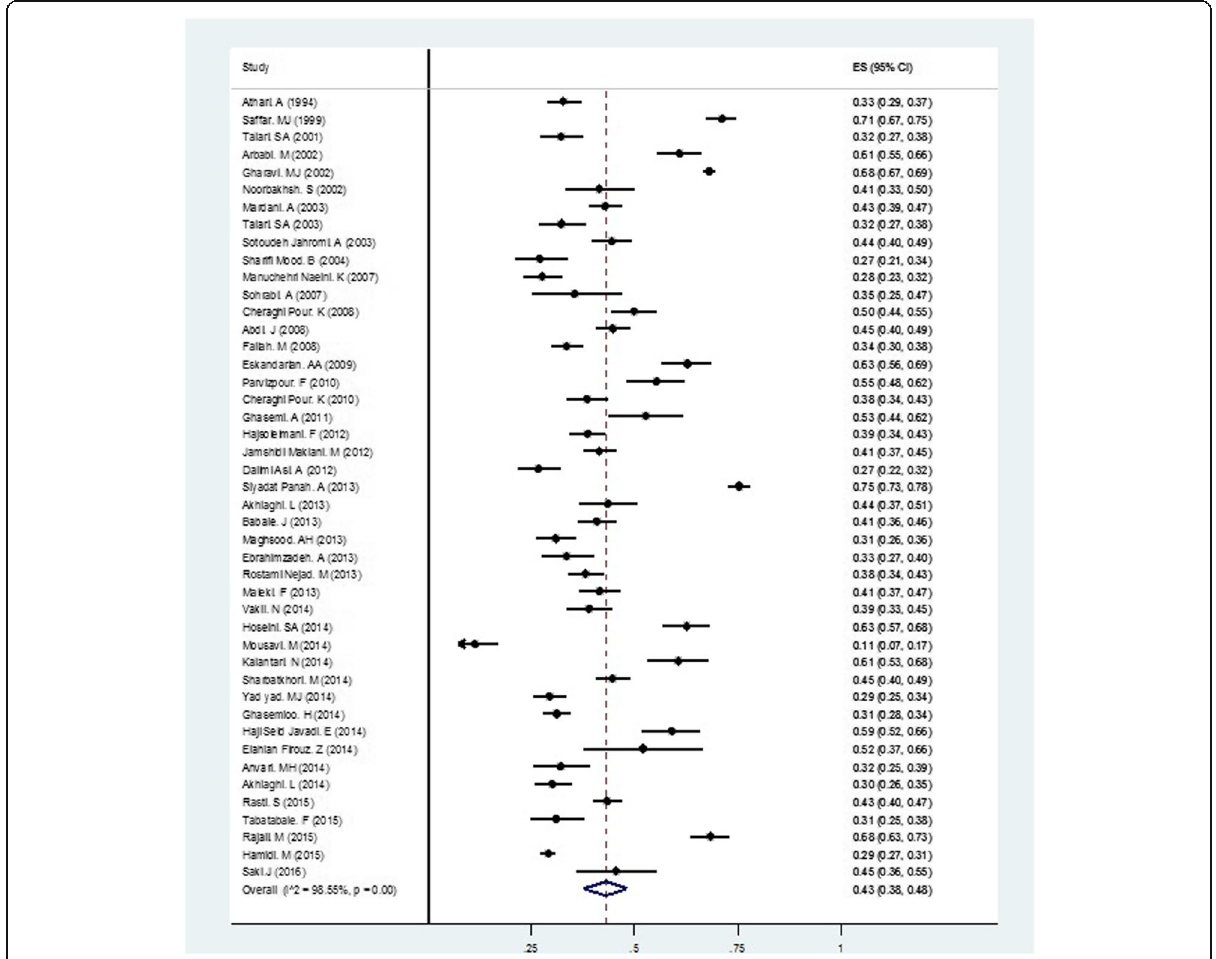
Fig. 3 Forest plot diagram of total prevalence of Toxoplasma gondii in pregnant women